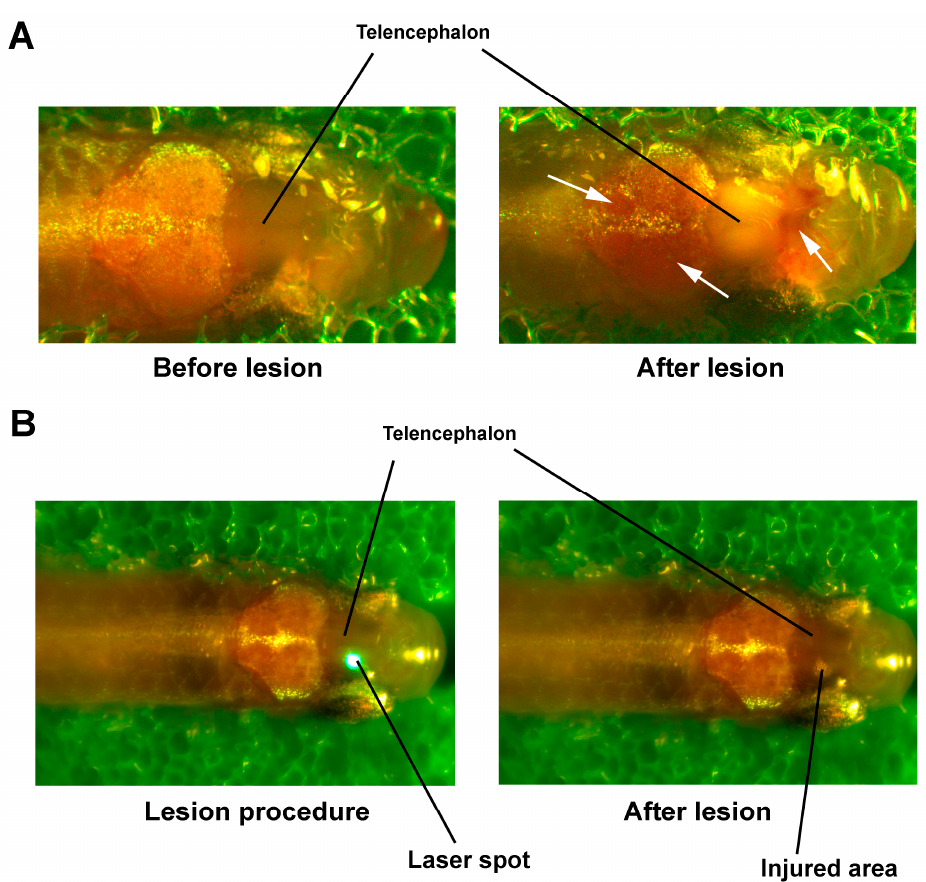
Figure 2. Laser-induced injury of the telencephalon in zebrafish. ( A ) Trauma of the whole telen- cephalon. White arrows show hemorrhages. ( B ) Local lesion of the right telencephalon. Sham-operated zebrafish were subjected to the same manipulations and procedures.